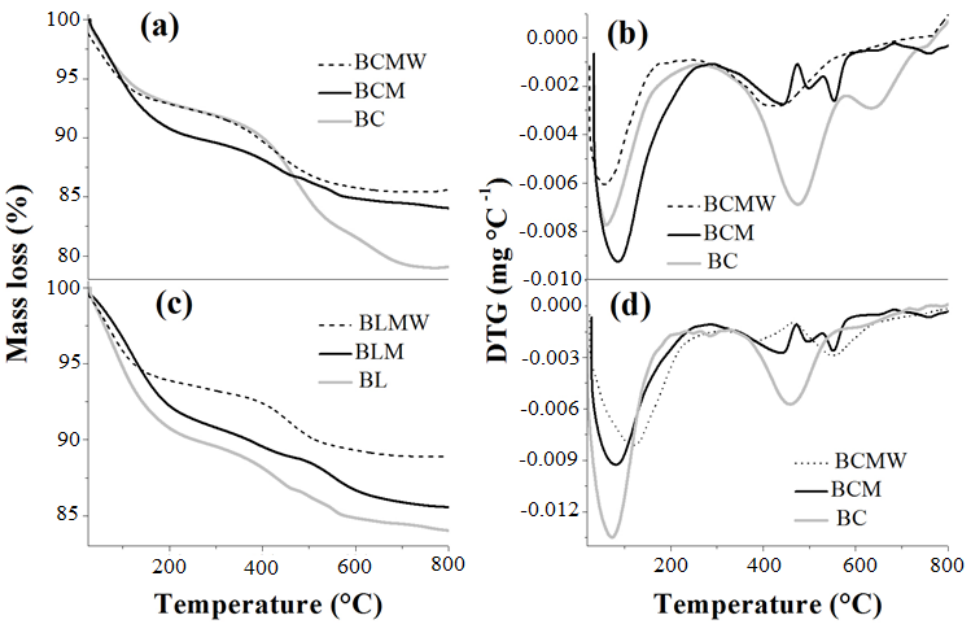
Figure 3. Thermogravimetric analyses TGA and DTG curves; ( a and b ) for BC, BCM and BCW samples; ( c and d ) for BL, BLM and BLMW samples. ( c , d ) for BL, BLM and BLMW